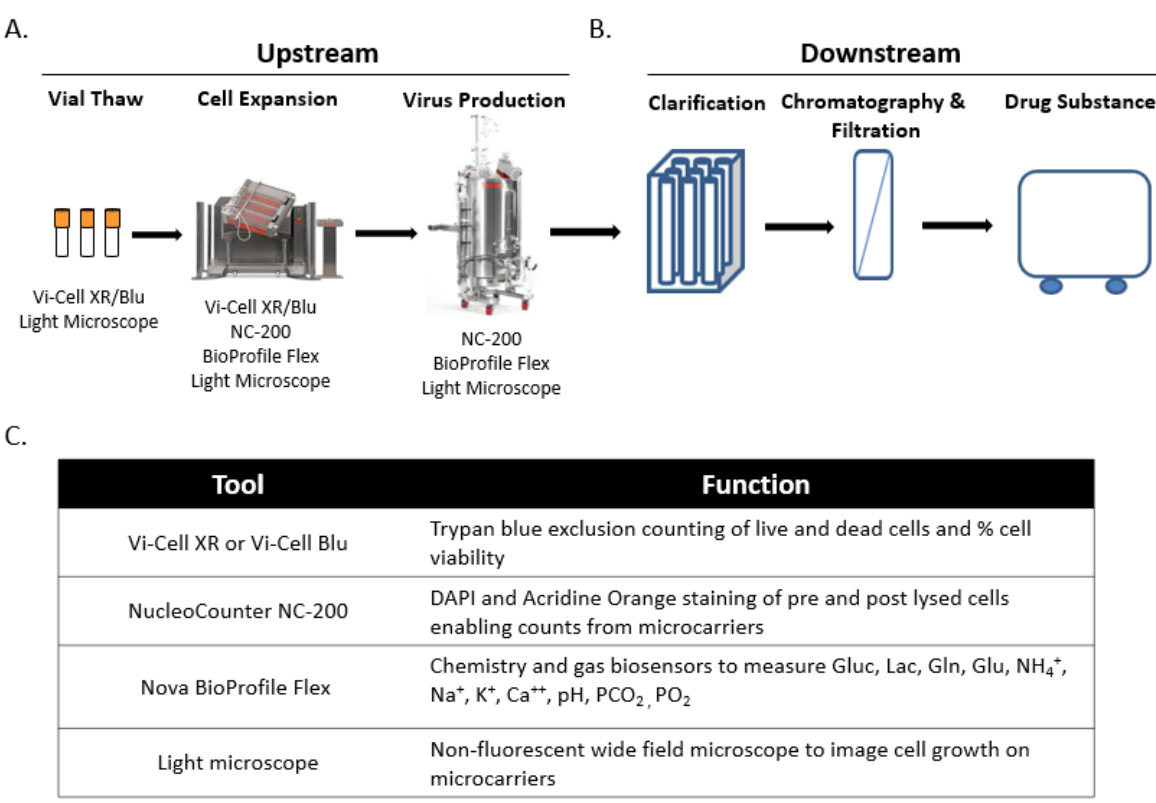
Figure 1. Depiction of a typical microcarrier live virus vaccine manufacturing process and associated in-process analytical tools. ( A ). The upstream LVV process starts with thawing a vial of cells that are planted and expanded in a series of cell stacks. The adherent cells are then taken from the cell stacks and planted in bioreactors on microcarrier beads to expand. During the cell growth stage, Vi-Cell and/or NC-200 counts are used to measure the viable cell concentration and viability. After growing on microcarriers in bioreactors for ~5 days, cells are infected with the virus of interest. During the virus production phase, NC-200 is used to measure viable cell concentration and viability. BioProfile Flex is used to monitor bioreactor pH and metabolites for both the cell expansion and virus production phases, and a light microscope is used as a visual indicator of cell viability and/or attachment to microcarriers throughout the entire upstream process. ( B ). The downstream process starts with obtaining harvested virus from the production bioreactor. The harvested virus is then processed through a series of clarification, chromatography, and filtration steps before being frozen as the final drug substance (DS). This process currently does not utilize any in-process analytical tools to monitor viral potency throughout downstream processing. ( C ). Table of the current in-process analytical tools used throughout the LVV manufacturing process and their